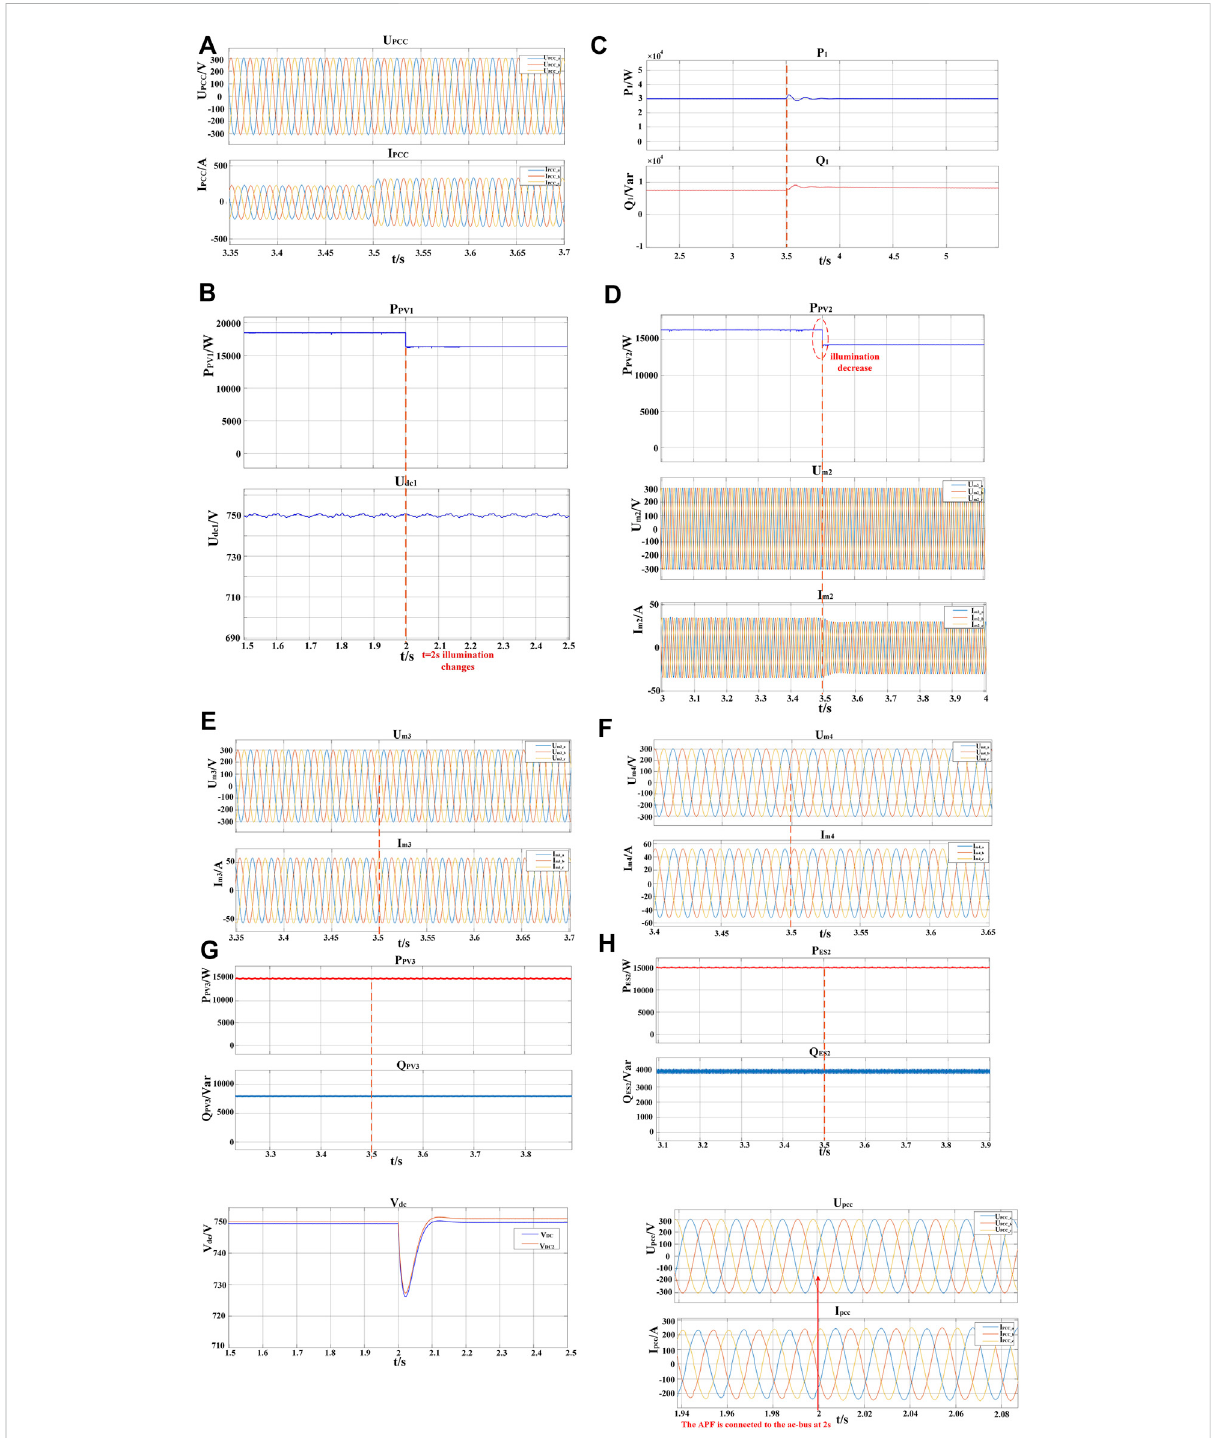
FIGURE 10 The output of the converters in the prosumer in normal grid-connected mode: (A) Voltage and current in PCC; (B) PV1 ’ s output power and the DC link voltage; (C) Output power of the integrated inverter; (D) Output of PV2; (E) Output of PV3; (F) Output of ES2; (G) The comparison between the DC link voltage of the interlinking converter and the voltage in dc-bus; (H) The voltage and current in